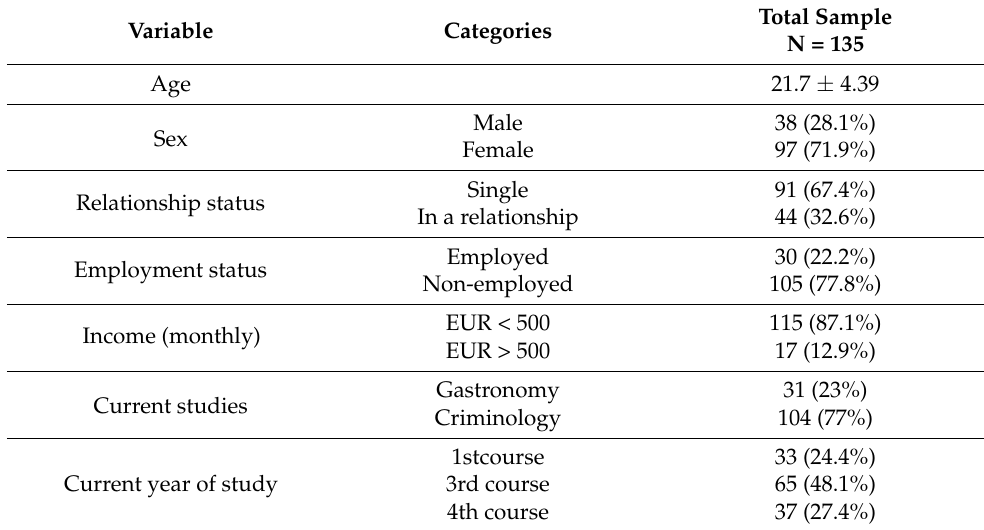
Table 1. Sociodemographic characteristics of the